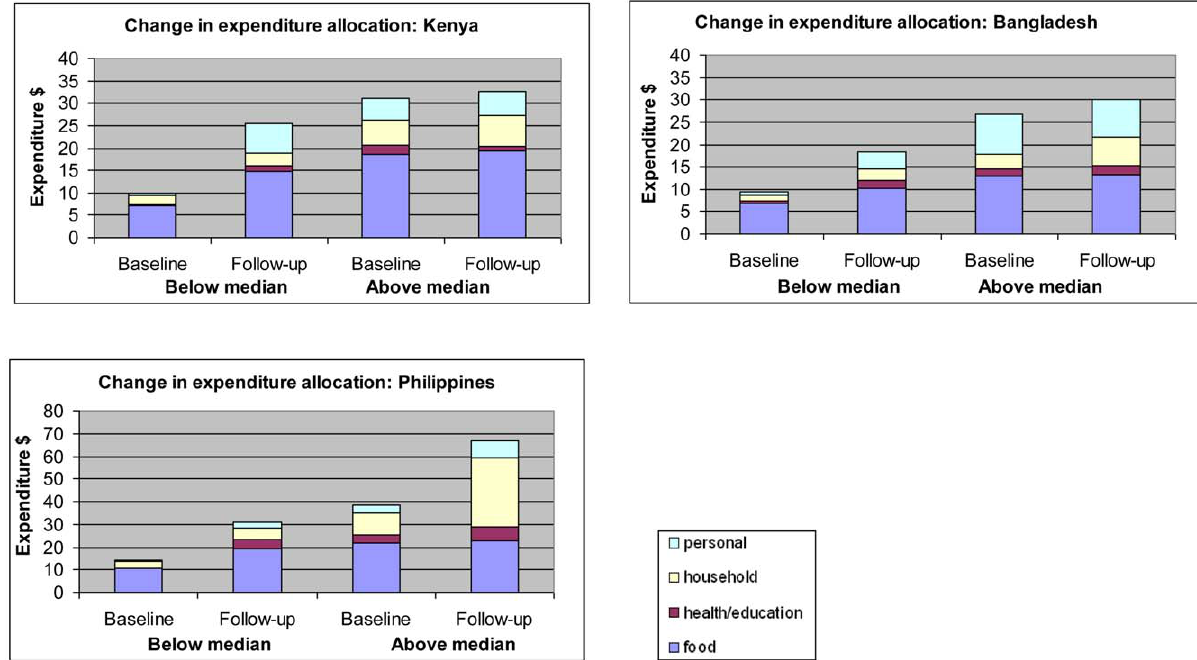
Figure 1. Change in allocation of expenses between baseline and follow-up among operated cases.